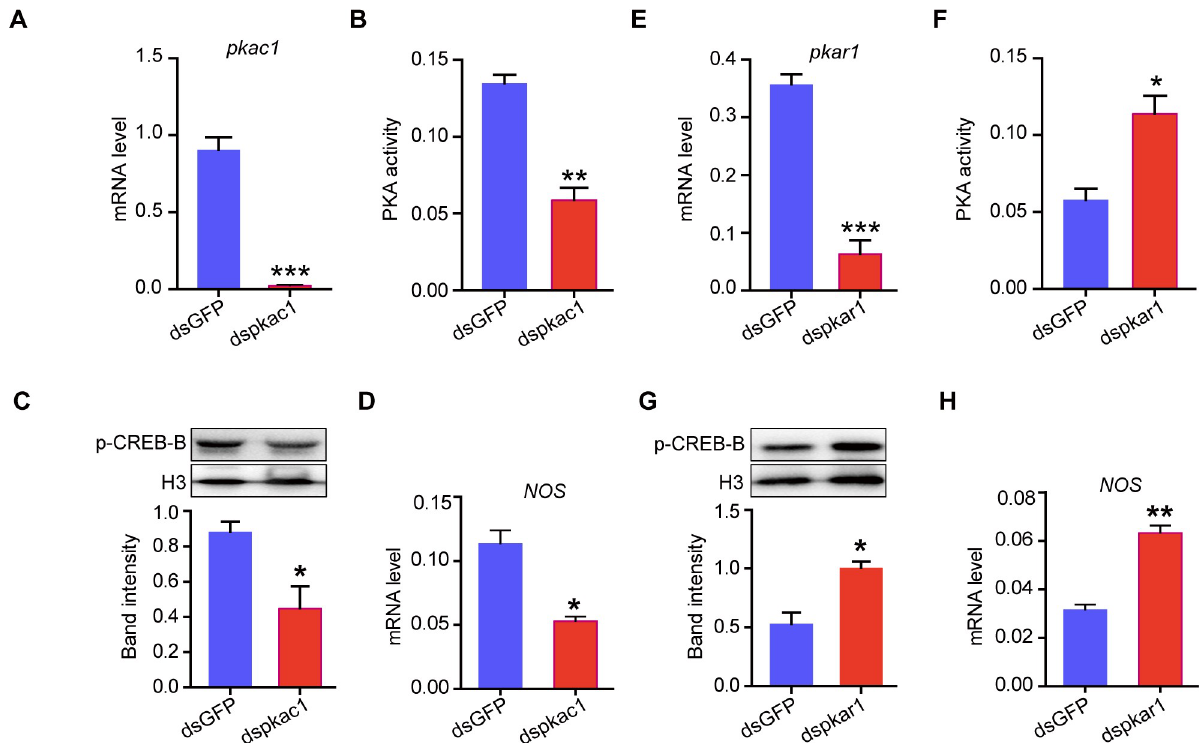
Fig 6. RNAi-mediated interferences of PKA activity change CREB-B phosphorylation and NOS transcription levels. (A) RNAi efficiency and (B) PKA activity after transcript knockdown of the catalytic C1 subunit of PKA encoding gene ( pkac1 ). Effects on (C) p-CREB-B and (D) NOS transcription levels after the transcript knockdown of pkac1 in G-phase locusts. (E) RNAi efficiency and (F) PKA activity after transcript knockdown of the regulatory R1 subunit of PKA encoding gene ( pkar1 ). Effects on (G) p-CREB-B and (H) NOS transcription levels after the transcript knockdown of pkar1 in S-phase locusts (n = 3 replicates, 6–8 locusts/replicate for qPCR, 8–12 locusts/replicate for western blot, � P < 0.05, �� P < 0.01, ��� P < 0.001 with Student’s t-test).